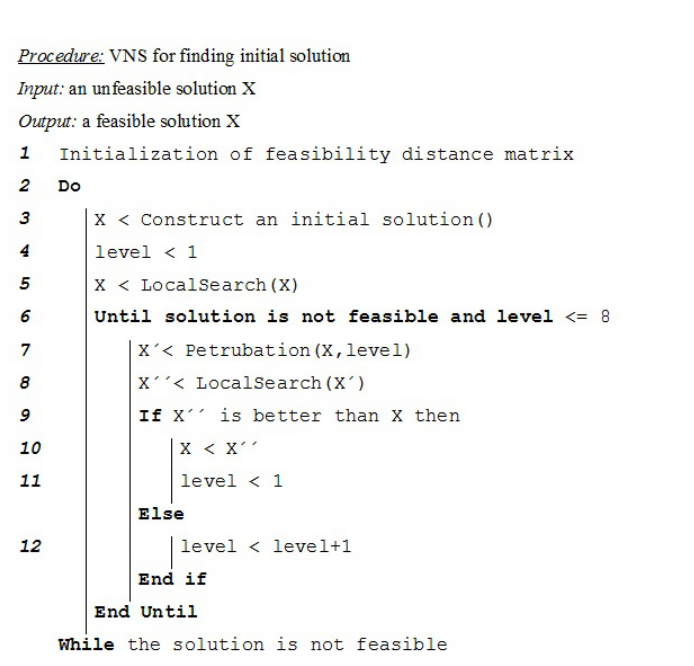
Figure 3. Pseudocode of the Meta-heuristic [4].